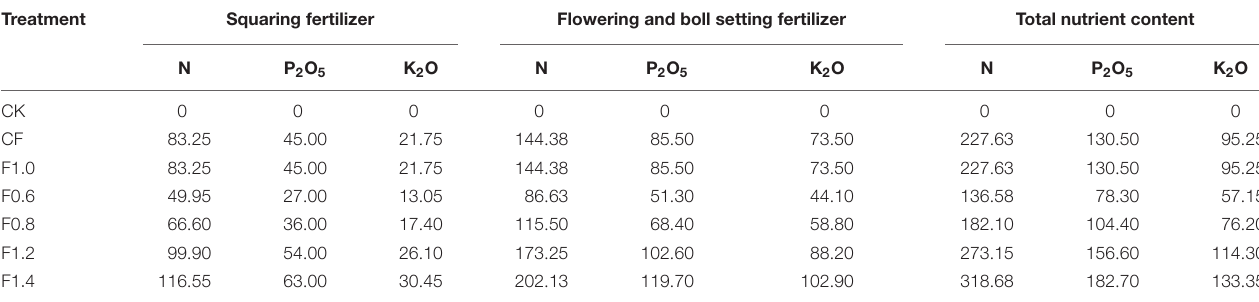
TABLE 1 | Fertilization schemes for different treatments (kg hm − 2